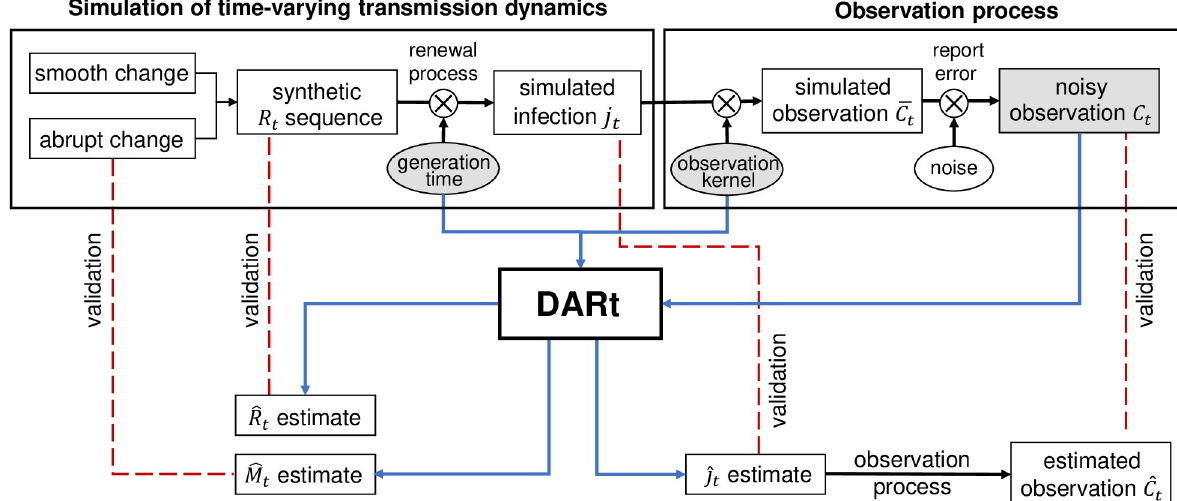
Fig 2. Validation experiment of the DARt system on simulated data. First, the ground-truth R t sequence is synthetic using piecewise Gaussian random walk split by several abrupt change points. The sequence of incident infection j the synthetic R t . The observation process includes applying a convolution kernel that represents the probabilistic observation delay to obtain the expected observation � C � and adding Gaussian noise that represents the reporting error to obtain the noisy ‘real’ observation C t to the DARt system are the distributions of generation time, observation kernel and simulated noisy observation C t . The system outputs are the estimated ^ R ^ , estimated ^ j ^ and change indicator ^ M ^ . These outputs are compared with the synthetic R t t t observation function is applied to the estimated ^ j ^ to compute the estimated observation ^ C ^ t